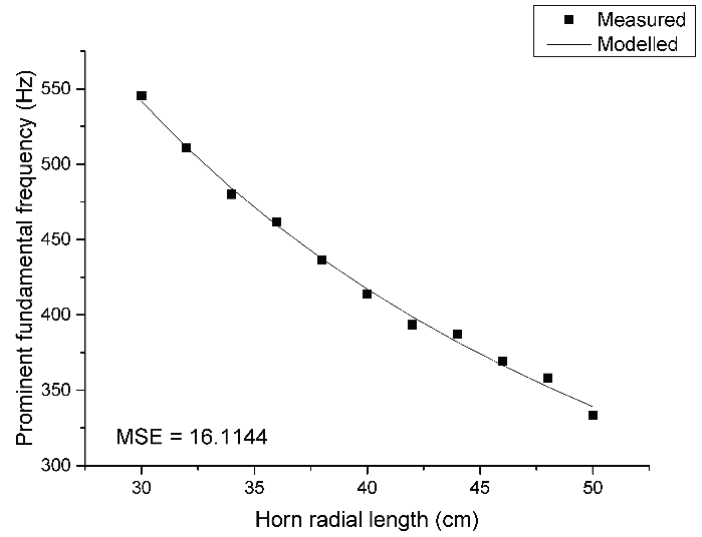
Figure 11. The measured and modelled fundamental frequency for ML structure lengths.